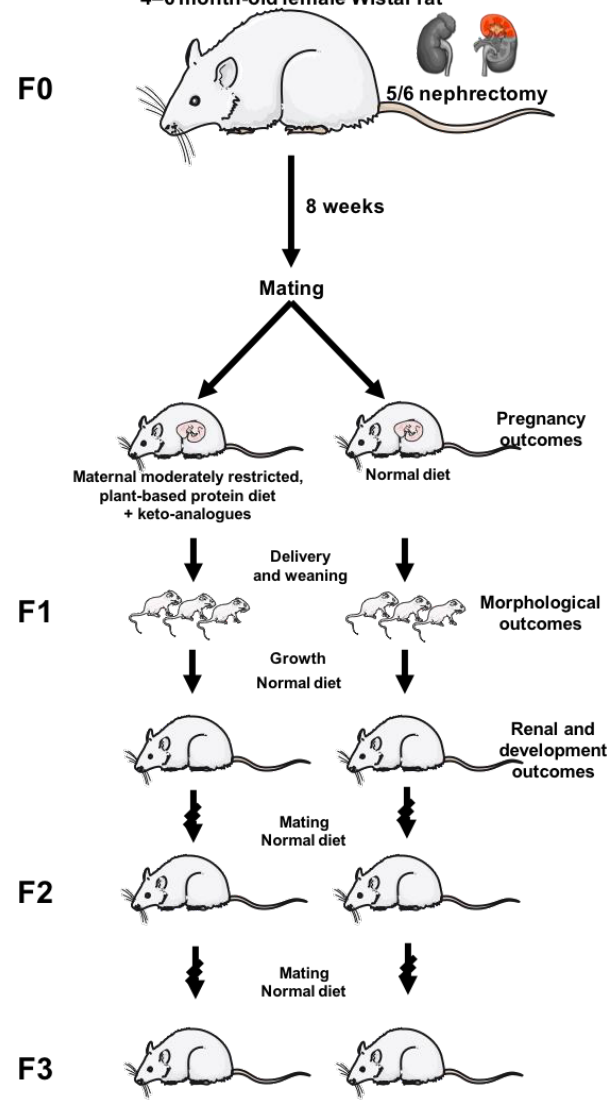
Figure 3. Design of a potential study to test the effectiveness of a moderately reduced-protein, vegetarian, supplemented diet in an animal model of chronic kidney disease.